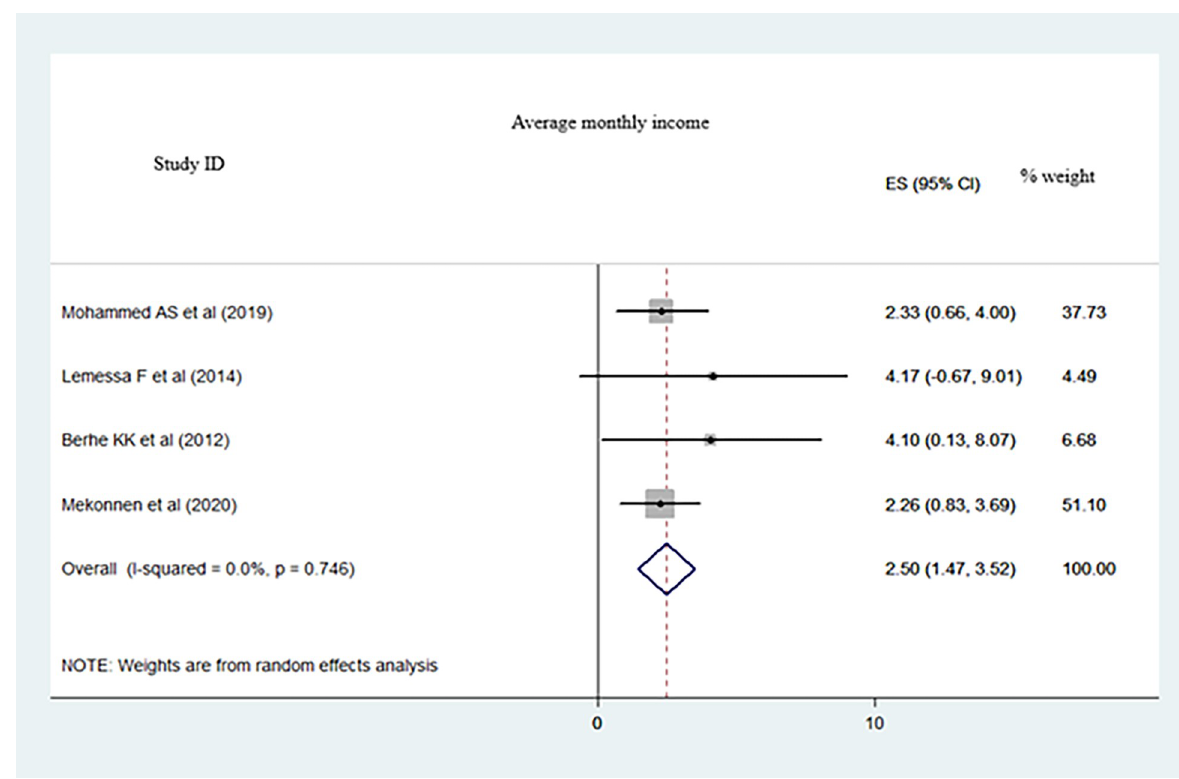
Fig 6. A meta-analysis of average monthly income associated with dietary adherence among type 2 DM population in Ethiopia.